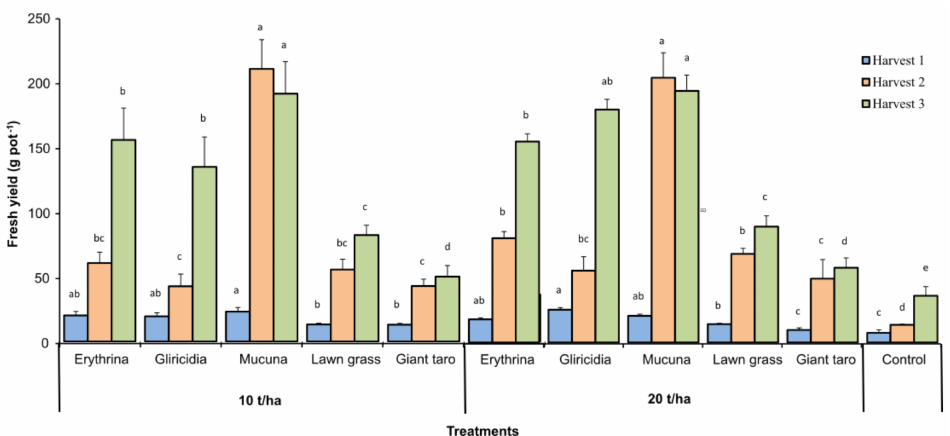
Figure 4. Interaction effect of organic amendments and their application rates (10 and 20 t ha − 1 ) on total fresh weight (g pot − 1 ) of Chinese cabbage harvested at 14, 28 and 42 days after transplantation. Treatments having different lowercase letters are significantly different from each other at p < 0.05.